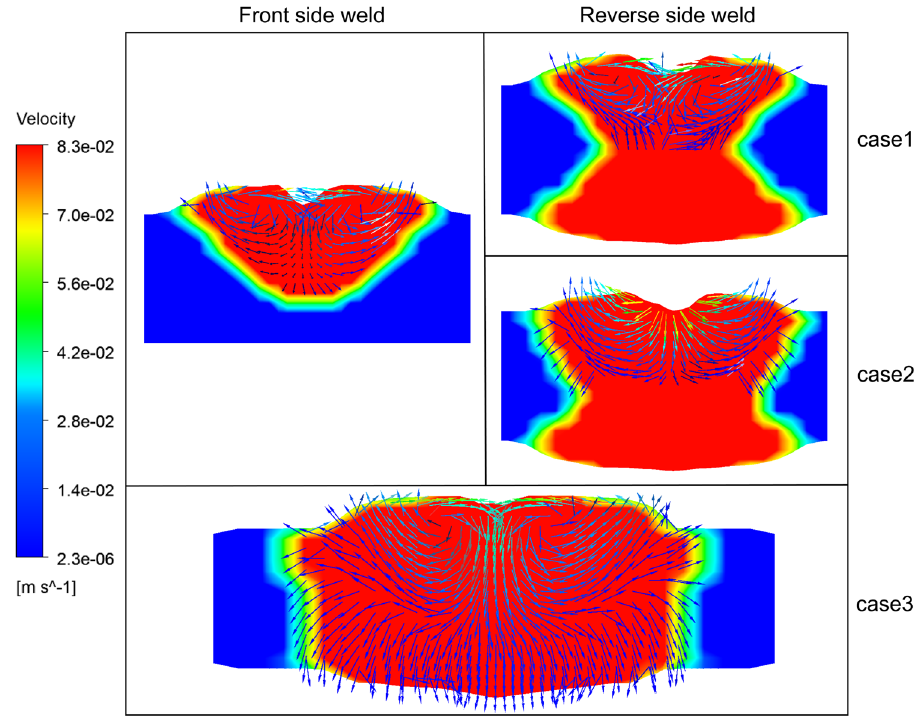
Figure 5: The velocity fi eld of the weld pool.